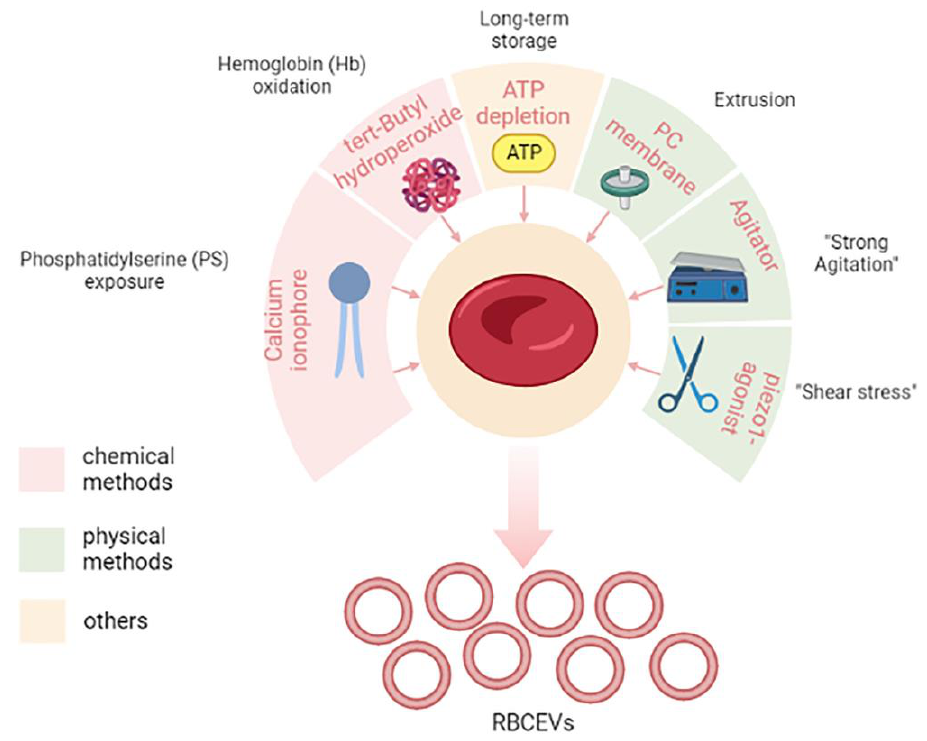
Figure 4. Methods for increasing the yield of RBCEVs production. In the figure, different chemical and physical methods are shown. In particular, molecules and/or mechanical stimuli are depicted together with their effect on the cells that give rise to RBCEVs release. Long-term storage is a particular condition that cannot be included in either the chemical or physical methods. Created in Biorender.com, accessed on 5 December 2022.